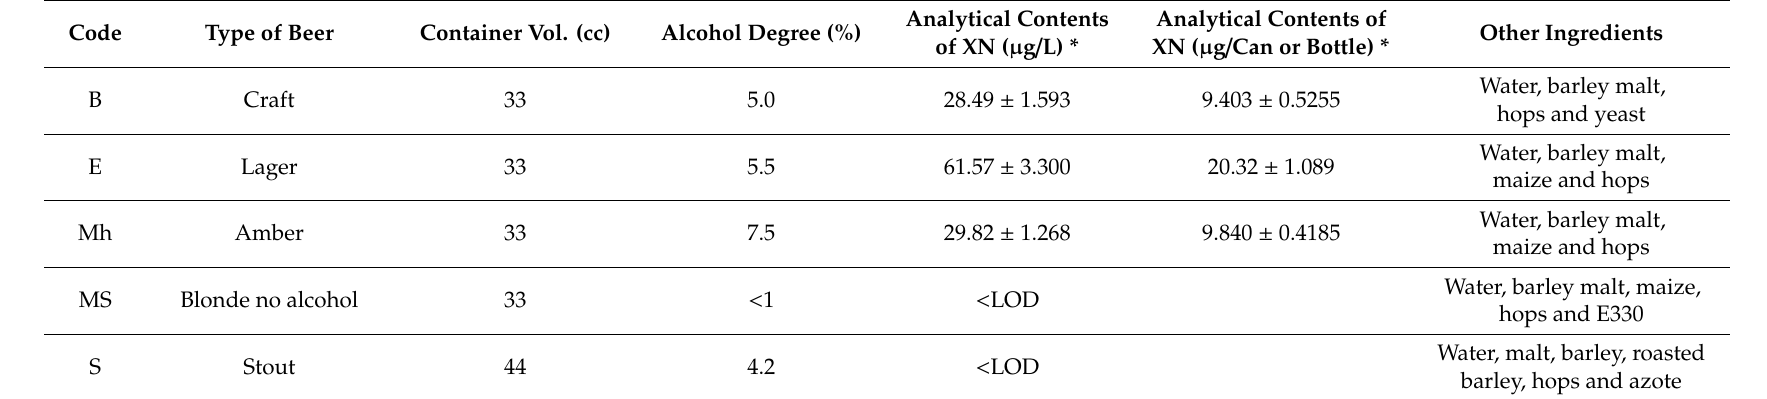
Table 3. Description of commercial beers samples and concentration of XN